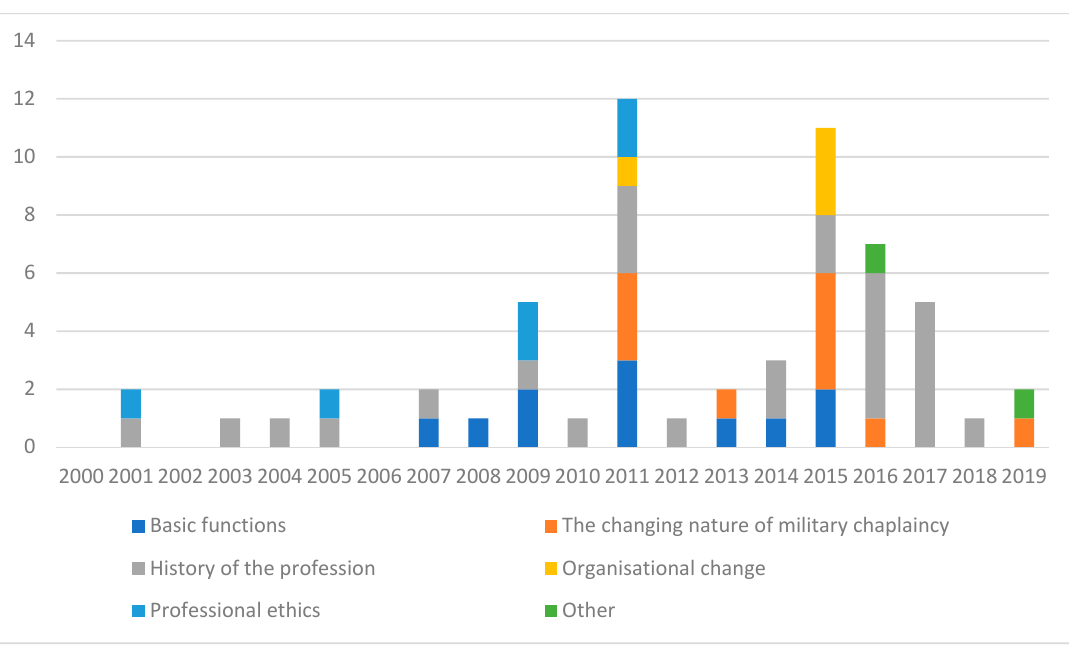
Figure A2. The variety of the topics handled in the articles.